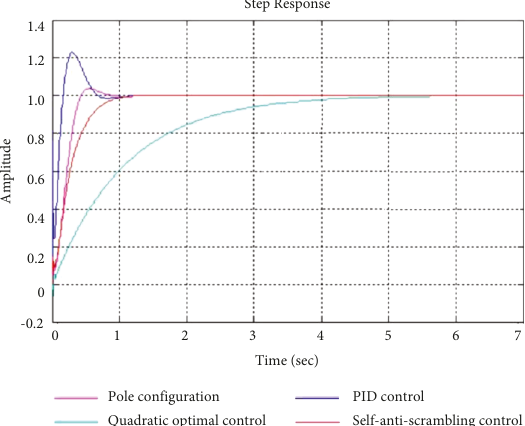
Figure 37: Response curve of control system based on four control